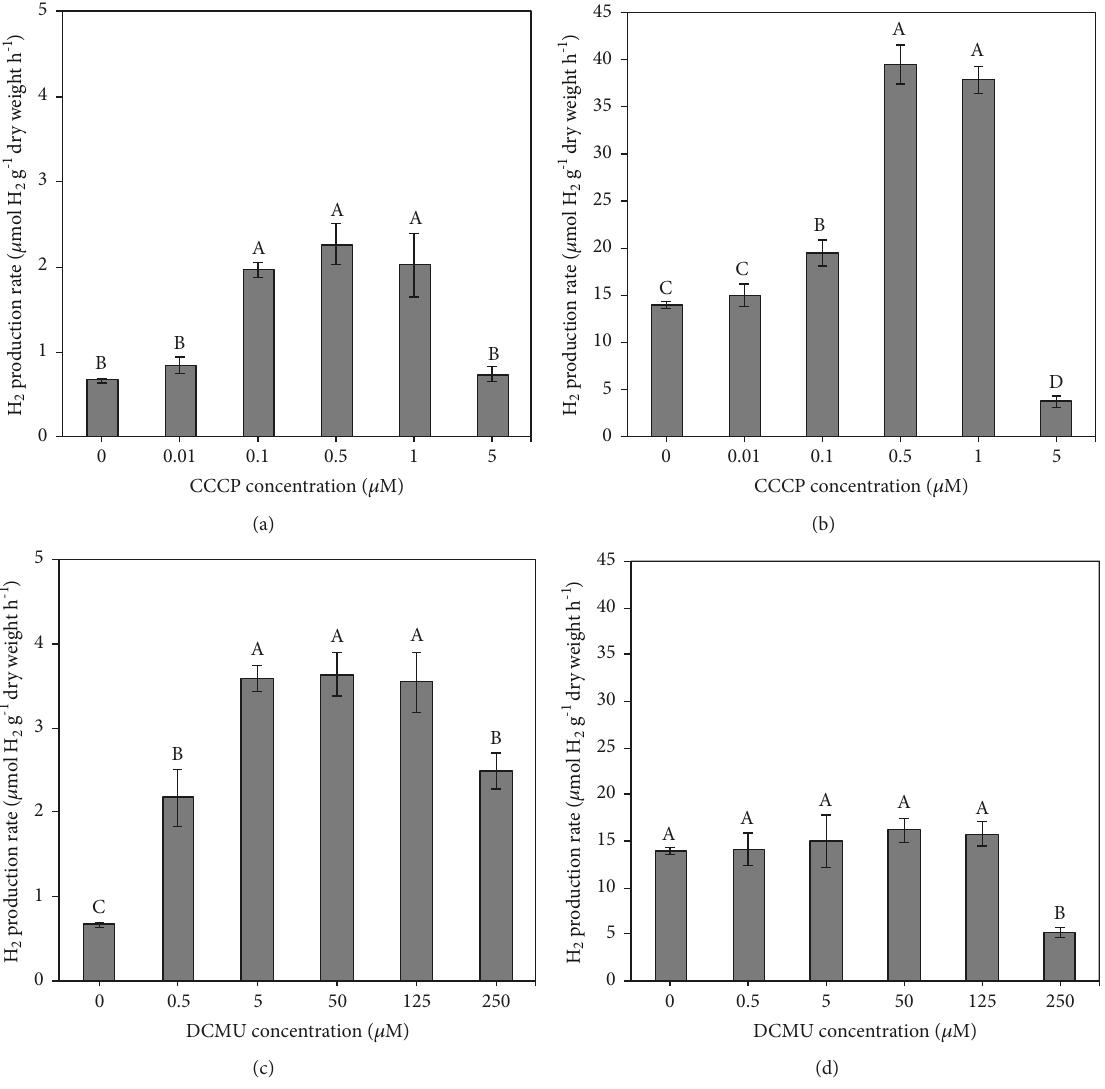
Figure 2: Effects of various concentrations of carbonyl cyanide m-chlorophenyl hydrazone (CCCP) and 3-(3,4-dichlorophenyl)-1,1- dimethylurea(DCMU)onH 2 productionrateby Aphanothecehalophytica after2hoursofincubationunderthelight(a,c)andunderdarkness (b, d). Data are means ± SD (n = 3). Different letters above columns indicate a significant difference according to Duncan’s multiple range test at p <